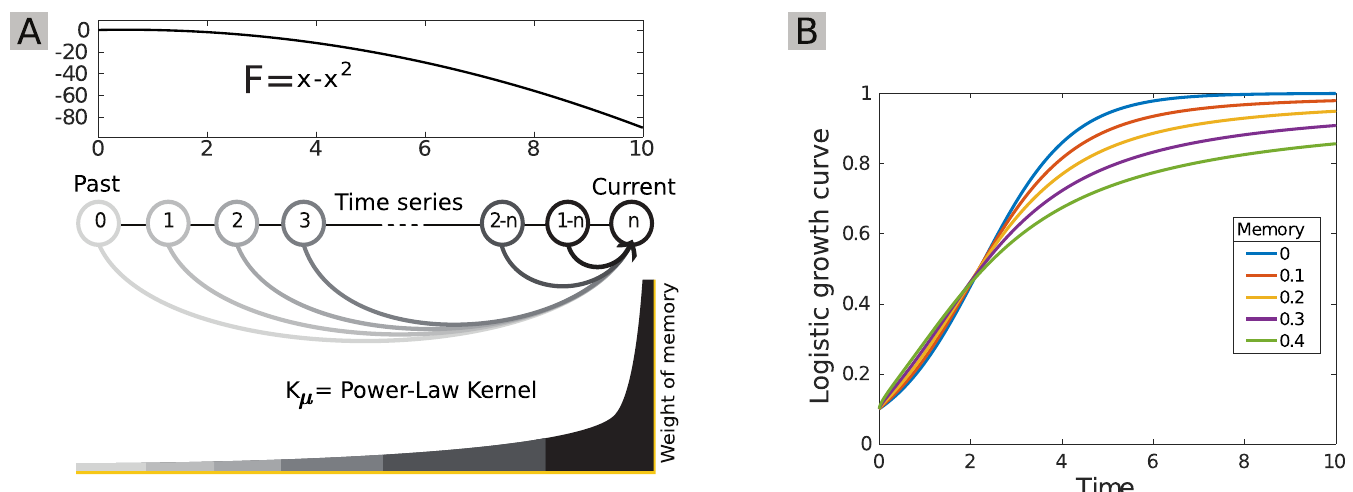
Fig 8. An intuitive interpretation of the memory introduced by fractional derivatives and of its effect on convergence time for the logistic curve. (A) The F function in Eq (4) for the standard logistic equation, and a sketch of the memory effects introduced by fractional derivatives on a time series: the weight of past states on the present decreases as a power-law of time. (B) Influence of a range of memory strengths on the classic logistic growth curve.